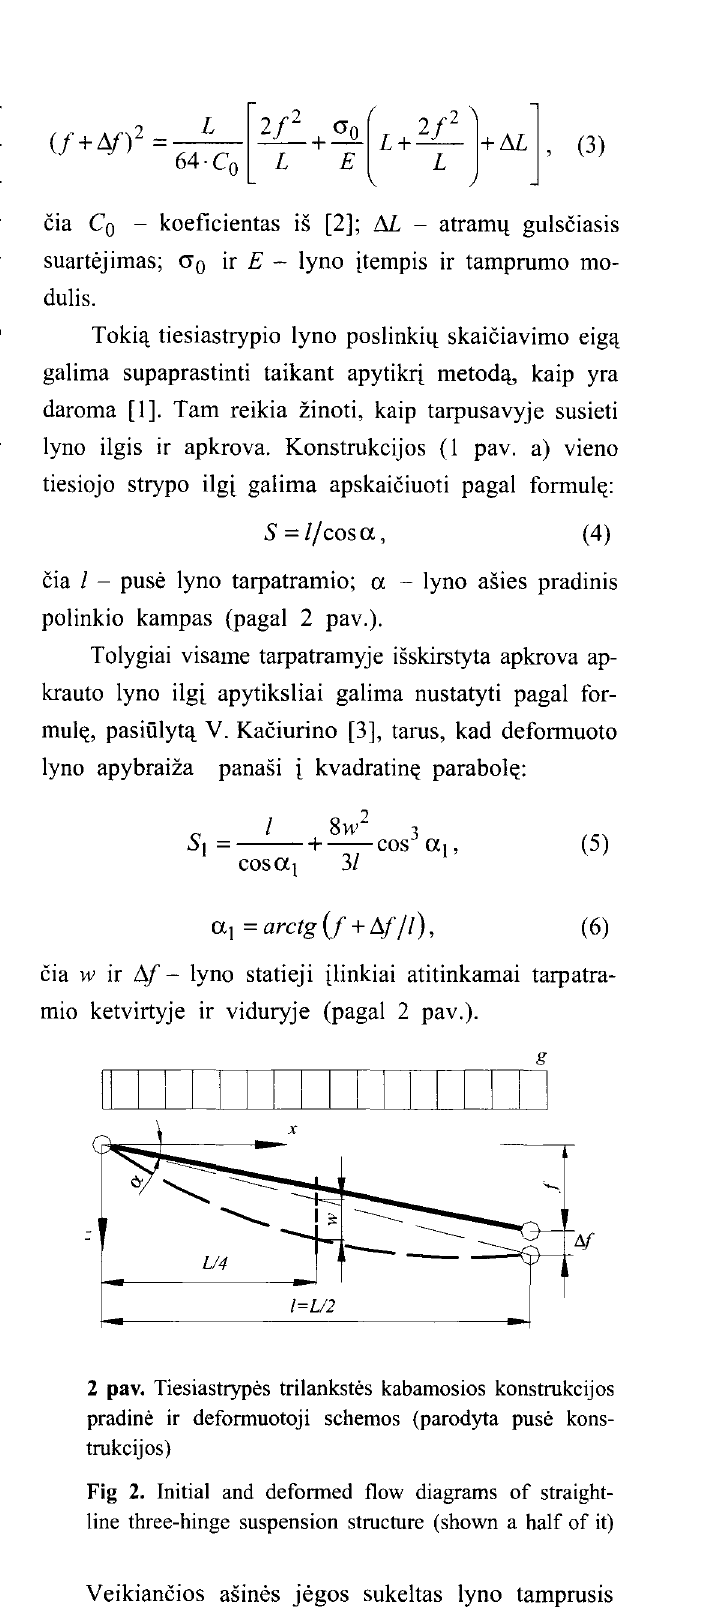
Fig 2. Initial and deformed flow diagrams of straight line three-hinge suspension structure (shown a half of